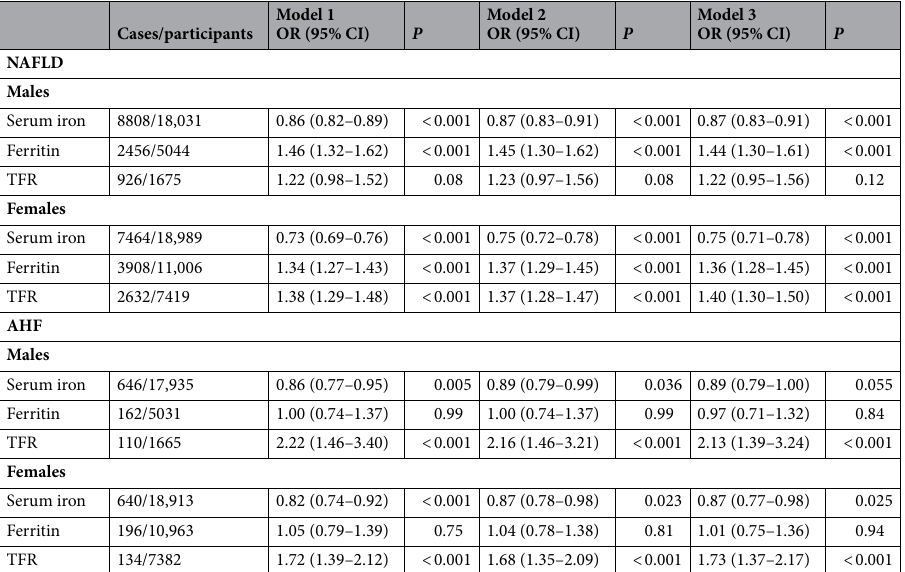
Table 4. Association between serum iron, ferritin, TFR (per SD increment) and the presence of NAFLD or AHF. Model 1: age (years), race (Mexican American, other Hispanic, non-Hispanic white, non-Hispanic black, other race), marital status (married or cohabitation, widowed or separated, never married), education level (less than 12th grade, high school or equivalent, college graduate or above), family poverty income ratio; Model 2: model 1 + smoking status (never, ever, current), alcohol intake (drinkers/week), leisure activity (MET- min/day), total energy intake (kcal/day), healthy eating index-2015; Model 3: model 2 + lead (μg/dL),